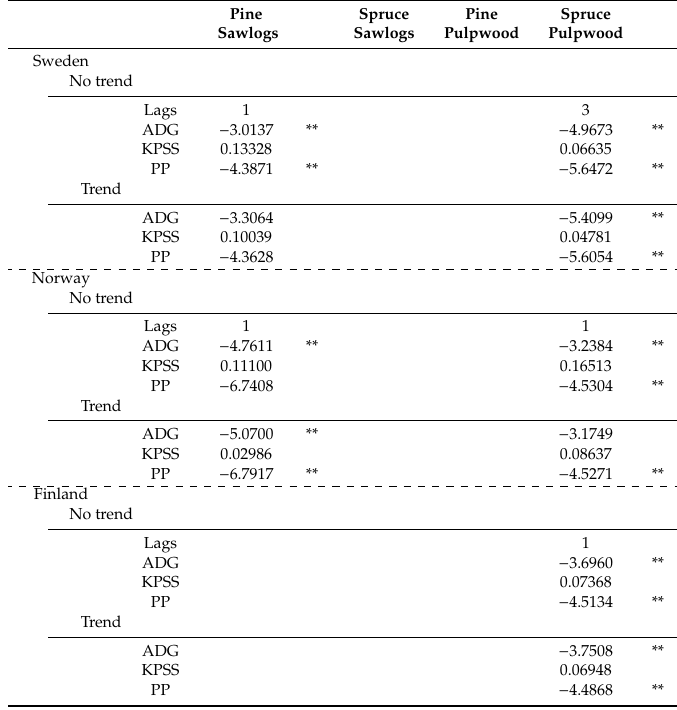
Table A2. Unit root and stationarity test results (prices in first-di ff erence).